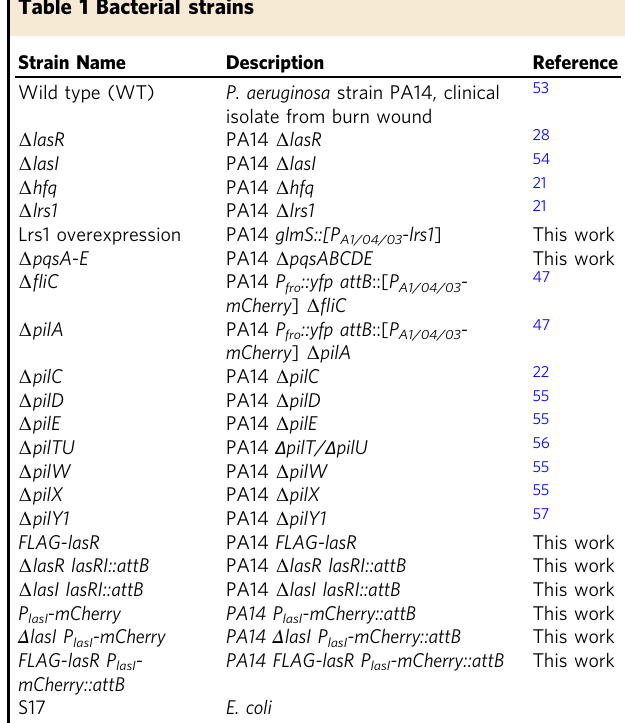
Table 1, all oligonucleotides are summarized in Table 2. Bacteria were routinely grown in Luria broth (LB) or LB solidi fi ed with 1.5% agar. For qRT-PCR and RNA- seq experiments, overnight cultures were diluted 1:1000 in LB and grown at 37 °C to OD 600 0.1. Cultures were transferred to petri dishes, and incubated on an orbital shaker at 100 rpm and 37°C. For the planktonic conditions, aliquots of